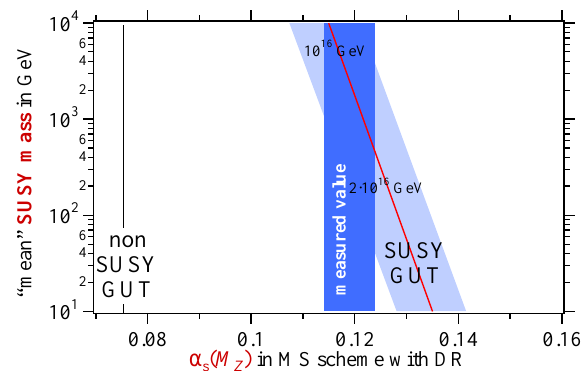
FIG. 10. (Color) a s prediction in supersymmetric GUT with minimal particle content in the dimensional regularization